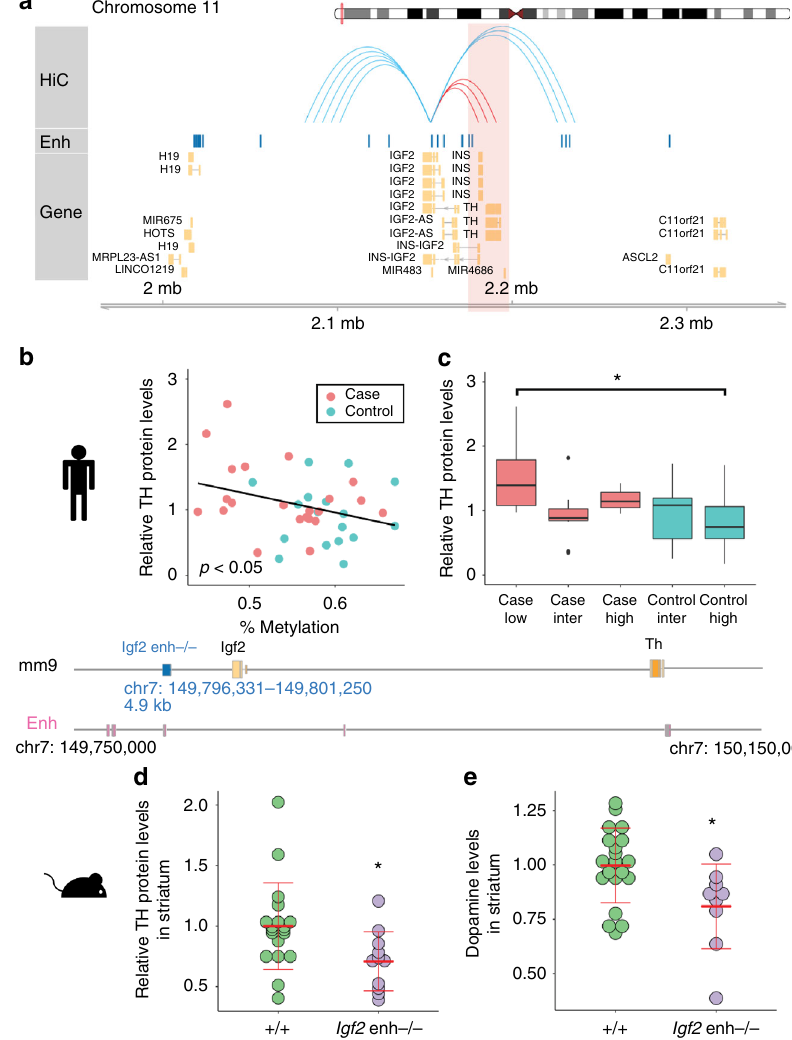
Fig. 3 The differentially methylated enhancer at IGF2 in major psychosis targets the dopamine synthesis enzyme tyrosine hydroxylase ( TH ). a Higher-order chromatin interactions of the differentially-methylated enhancer at IGF2 with the TH gene in the human prefrontal cortex 90 ; interactions within ±100 kb are shown. Blue arcs show all interactions from the location, and red arcs highlight those to the TH gene. Enh: Chromatin states re fl ecting enhancers in adult frontal lobe 91 (blue rectangles). b Reduced DNA methylation at the IGF2 enhancer in major psychosis correlates with increased TH protein levels in the prefrontal cortex ( R = − 0.32, p < 0.05; linear regression; n = 17 controls (blue circles) and n = 22 cases (red circles)). TH protein levels are normalized to NeuN, INA, and actin. c DNA methylation at the IGF2 enhancer is associated with differing TH protein levels between cases and controls (same data as b ). Low, mid, or high DNA methylation ( < 50%, 50 – 60%, and > 60%, respectively). Left to right: n = 8, 11, 3, 9, and 8 samples for cases (red boxplots) and controls (blue boxplots). Main effect of DNA methylation by two-way ANOVA F (2, 35) = 3.5, p < 0.05; * p = 0.05 by Tukey post-hoc test. Boxplot center indicates median; box bounds indicate 25th and 75th percentile, and whiskers mark 1.5 times the interquartile range. d , e Effect of Igf2 enhancer deletion knockout in mice. Schema shows deletion of the 4.9 kb Igf2 enhancer alongside mouse forebrain enhancers (ENCODE 92 , pink). d TH protein levels in striatum of adult wild-type ( + / + ; n = 19 mice; green circles) and Igf2 enh − / − ( n = 11 mice; purple circles) mice (normalized to NeuN and actin). Data points shown along with mean±standard deviation. e Dopamine levels in striatum of adult wild-type and Igf2 enh − / − mice measured by HPLC ( n = 20 and 9 mice, respectively). Data normalized to wild-type levels. * p < 0.05 by one-way